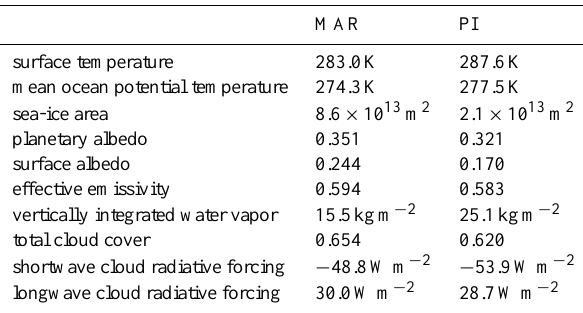
Table 3. Global annual-mean values of key climate variables for the Marinoan (MAR) and pre-industrial (PI) control simulations. Planetary albedo and effective emissivity are calculated using global annual-mean radiative